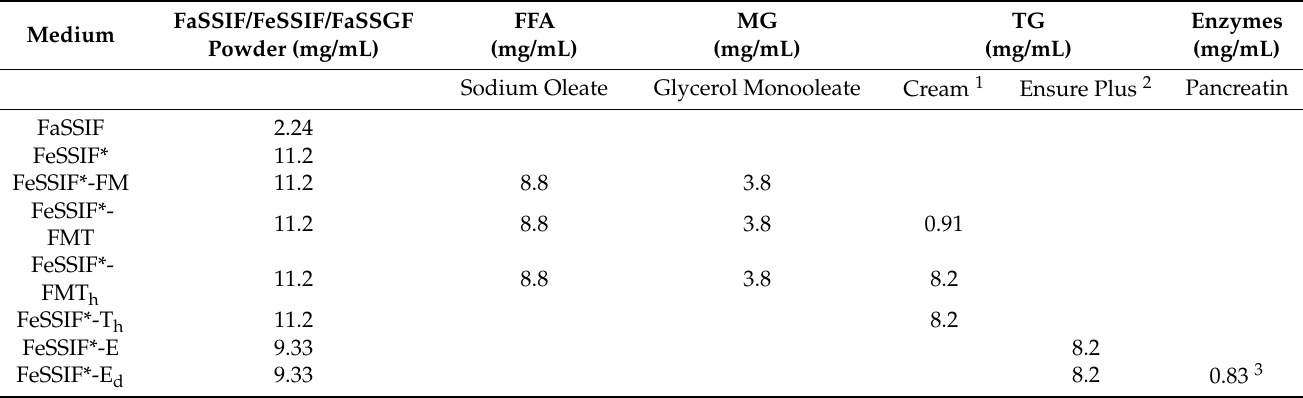
Table 1. Composition of FaSSIF and simulated media reflecting the fed state used for in vitro and in situ